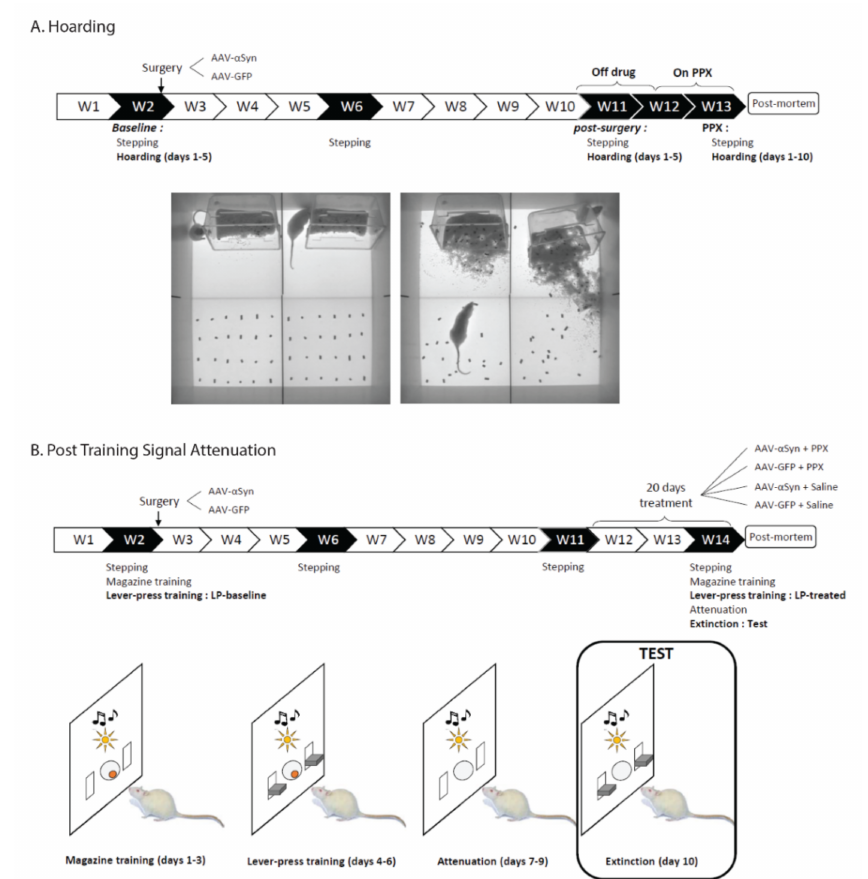
Figure 1. Experimental design. ( A ) Timeline of experiment 1 (hoarding). After baseline assessment of motor function (stepping) and of hoarding behavior, bilateral lesion of the substantia nigra pars compacta was achieved via viral-mediated bilateral overexpression of α -synuclein. Stepping was performed again at 4 and 9 weeks after surgery. Hoarding behavior was assessed at 9 weeks post- surgery (Off PPX) and at 11 weeks, during 10 days of PPX administration (0.3 mg/kg/day, s.c.). Hoarding behavior was assessed during 30 min session in a 100 × 50 cm open field. Pictures show the configuration of the task at the beginning (left) and at the end of a hoarding session (right). ( B ) Timeline of experiment 2 (Post training signal attenuation task). After baseline assessment of motor function (stepping), rats were trained to collect 45 mg sucrose pellets from the magazine (magazine training), then to press a reinforced lever in order to obtain a 45 mg sucrose pellet reward (Lever-press (LP) training: LP baseline). Bilateral lesion of the substantia nigra pars compacta was achieved via viral-mediated bilateral overexpression of α -synuclein and the stepping test was performed again at 4 and 9 weeks after surgery. Animals then received PPX (0.3 mg/kg/day, s.c.) or saline for 20 days. 10 days after the initiation of PPX treatment, magazine training was performed, followed by lever-press training, attenuation, and extinction. During magazine training (days 1–3), both levers were retracted and the occurrence of a compound stimulus (light + tone) indicated reward availability in the magazine. During lever-press training (days 4–6), both levers were available and pressing the reinforced lever triggered the presentation of the compound stimulus and the